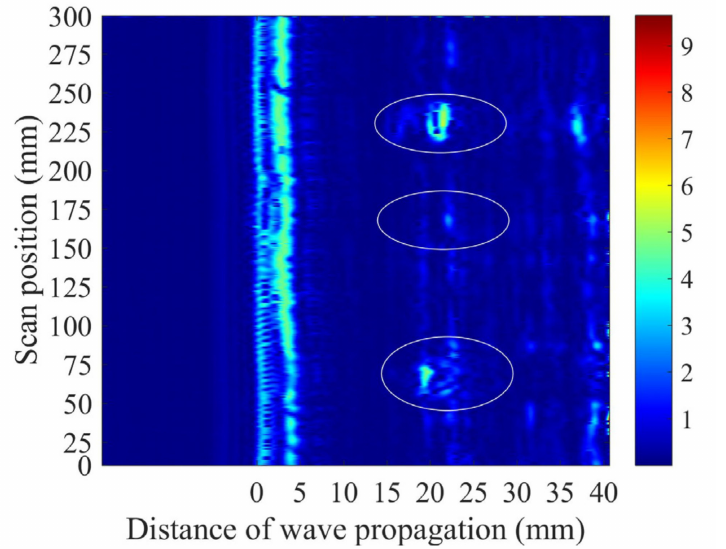
Figure 8. B-image for the weld specimen obtained using the A-wave signals. The real flaws and their positions are marked in the ellipses, but there are suspected flaws outside these regions.